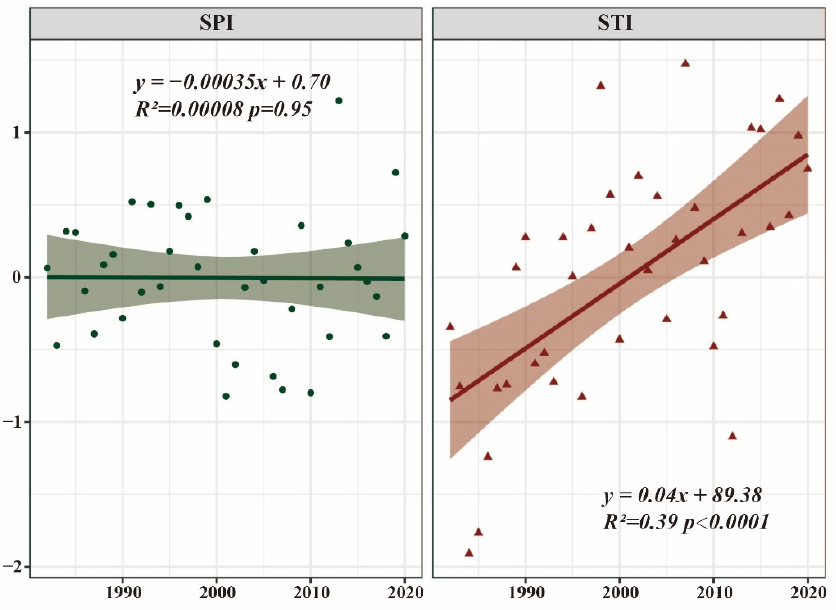
Figure 12. Temporal trends of SPI and STI in Inner Mongolia from 1982 to 2020.